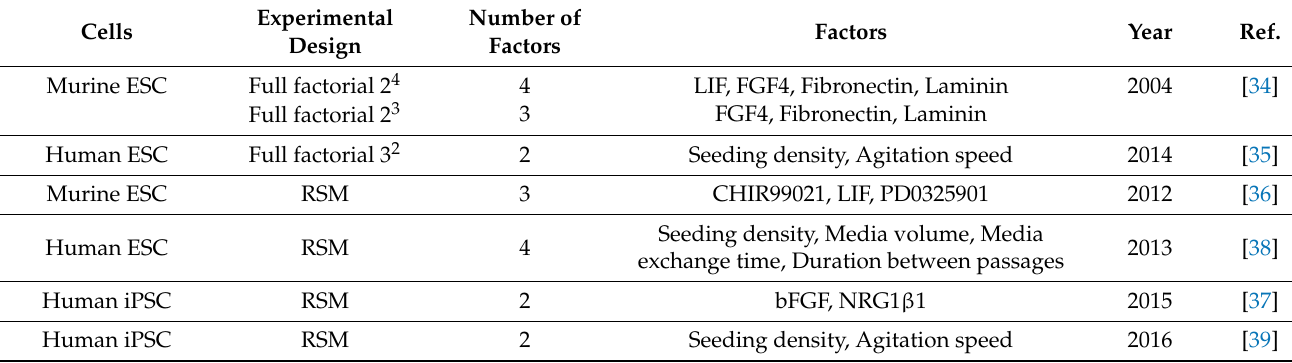
Table 1. DOE studies investigating PSC